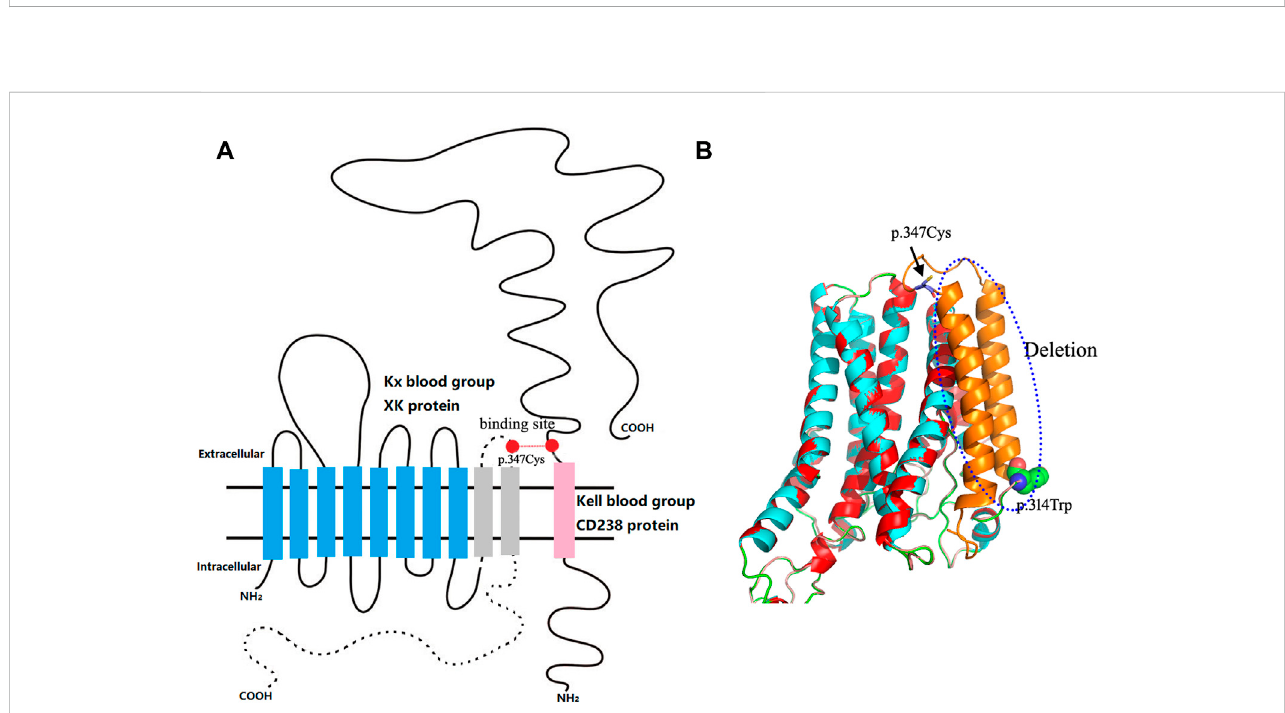
FIGURE 3 Structural analysis of the patient ’ s truncated XK protein. (A) Schematic diagram of the 10-transmembrane structure of the XK protein. The blue column indicates the retained transmembrane structure of the truncated XK protein; the dotted line and gray column represent deleted structures of the truncated protein, including the last two transmembrane structures, the last extracellular domain, and the entire C-terminal intracellular peptide segment. The red dots are binding sites XK Cys347 – Kell Cys72 . This schematic representation is based on the base model constructed by Roulis et al. (2018). (B) Comparison of 3D conformations of mutant and wild-type XK proteins. The red and blue areas represent the overlapping regions; the blue dashed box is the deleted structure; the globular amino acid structure represents the truncation point of the protein. The rod-shaped amino acid indicated by the black arrow corresponds to the missing binding site of the Kell blood group